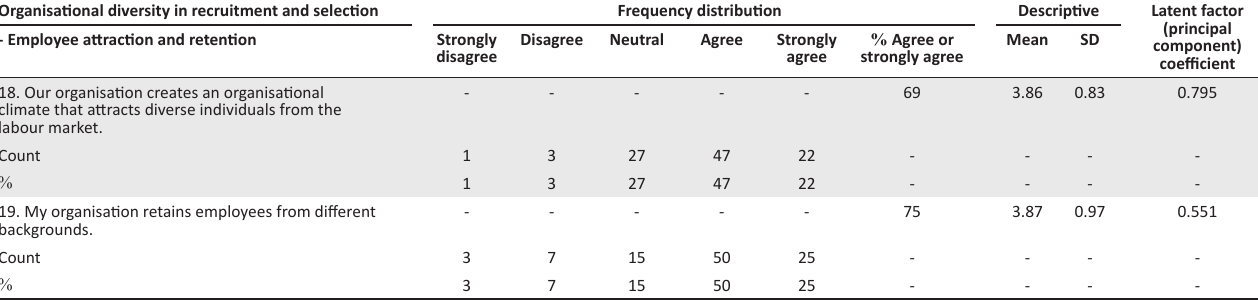
TABLE 6: Analysis of the sub-construct of employee attraction and retention.